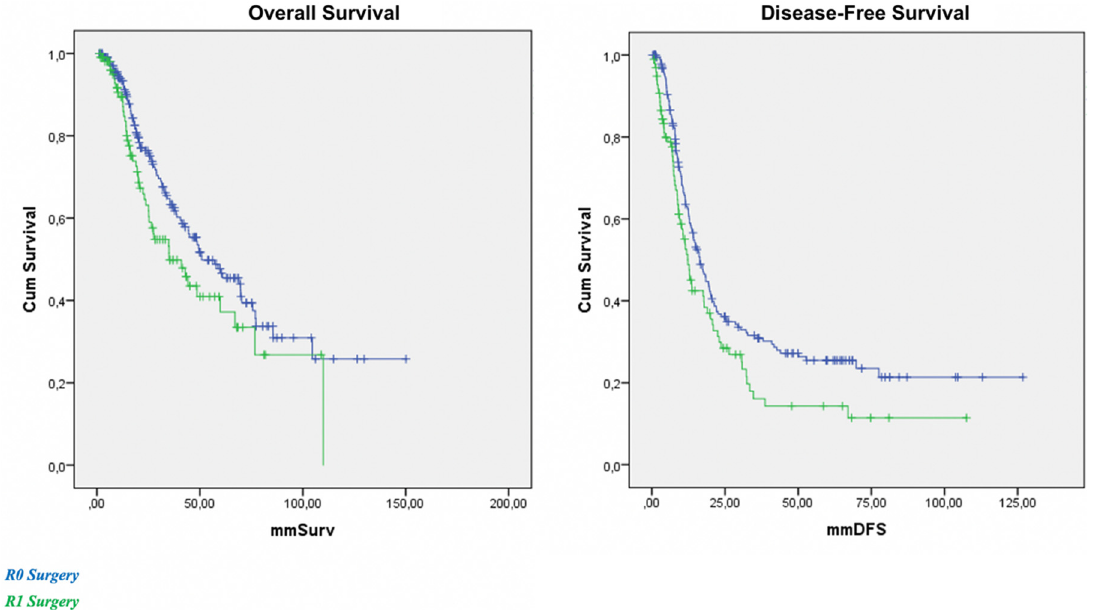
Figure 2. Overall survival (OS) and disease-free survival (DFS) in R0 (blue) and R1 (green) patients. In terms of treatment at relapse, 17.7% (30/169) of patients underwent a second surgery (R0 = 14, R1 = 6, R2 = 3, exploratory laparotomy = 7) while 26 received a locoregional approach; the most common treatment was radiofrequency ablation (n = 22).